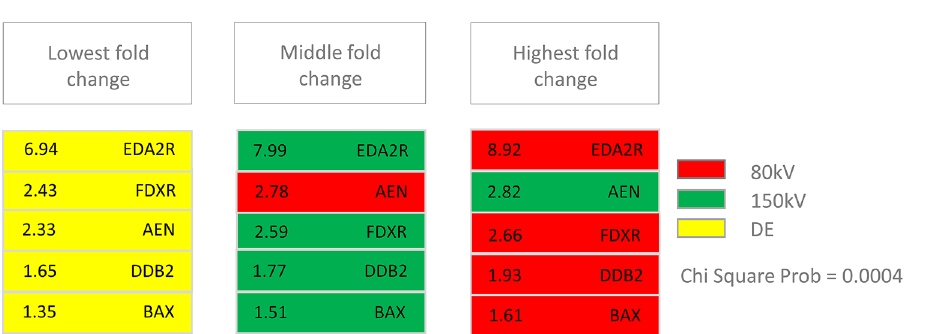
Figure 4. Frequency distribution of mean fold changes on a linear scale for the genes EDA2R , FDXR , AEN , DDB2 and BAX . Mean fold changes for each gene and treatment averaged over all probands and replicates were categorized according to whether they represent the lowest, middle or highest fold change of each gene. Exposure groups are indicated by red (80 kV), green (150 kV) and yellow (dual-energy (DE)) coloring of boxes. Mean fold changes given in the boxes refer to qRT-PCR results based on nine measurements (3 probands × 3 technical replicates per proband). See “Results” section for